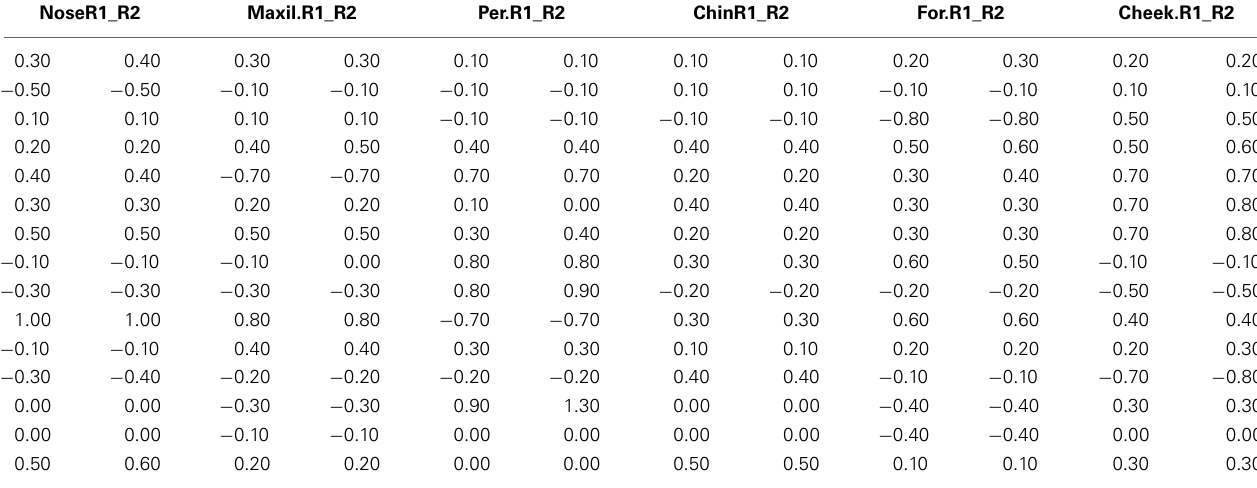
Table 1 | The degree of temperature change from one condition to another based on the coding of two independent